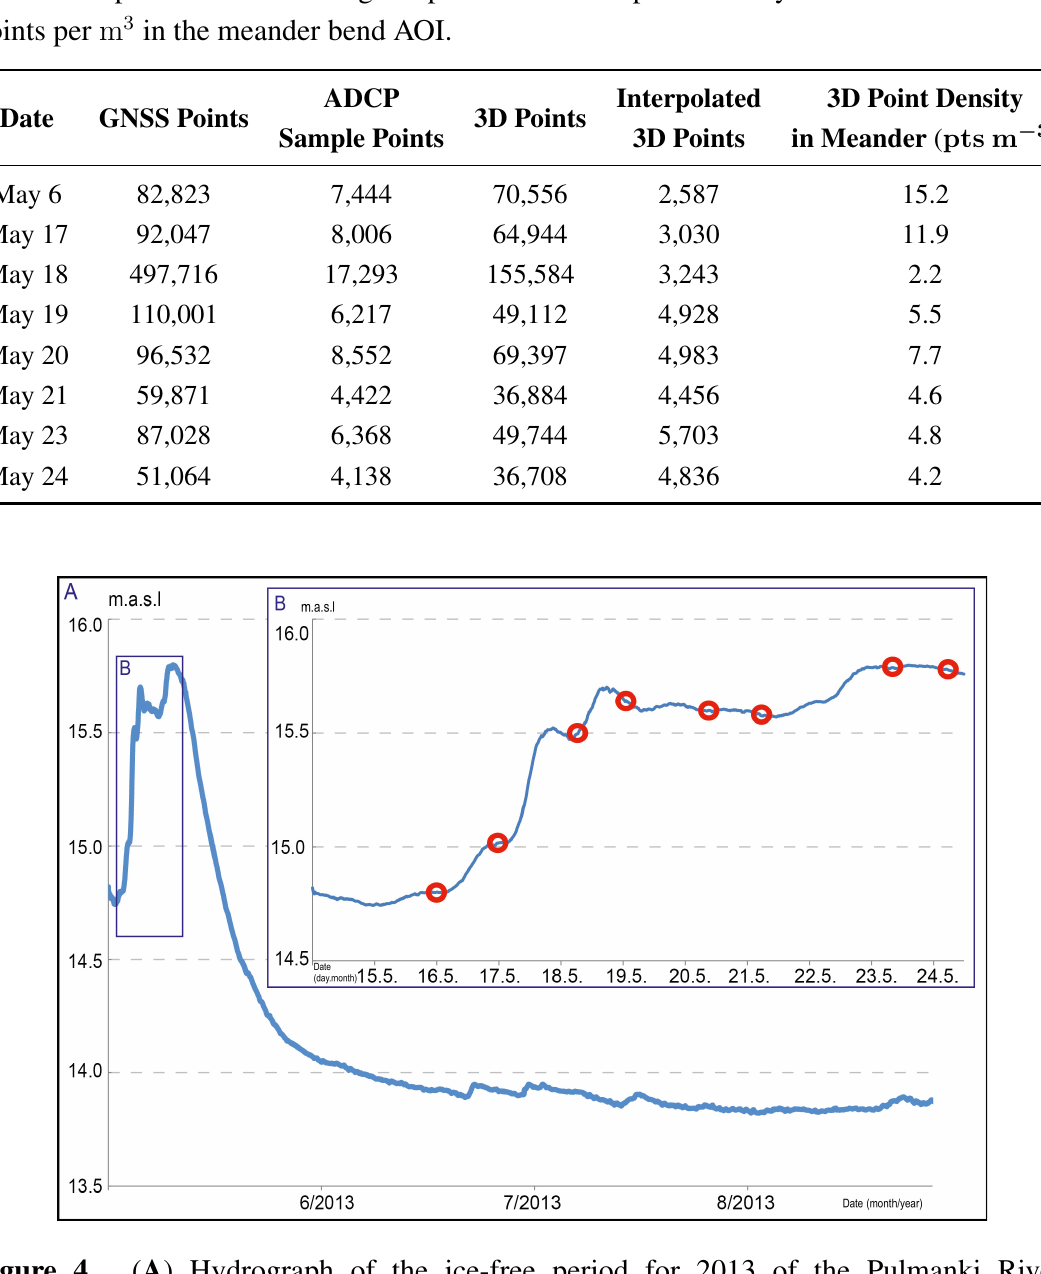
Figure 4. ( A ) Hydrograph of the ice-free period for 2013 of the Pulmanki River; ( B ) The rising stage of the spring flood is in meters above sea level (m.a.s.l). ADCP-flow measurement times are indicated with red